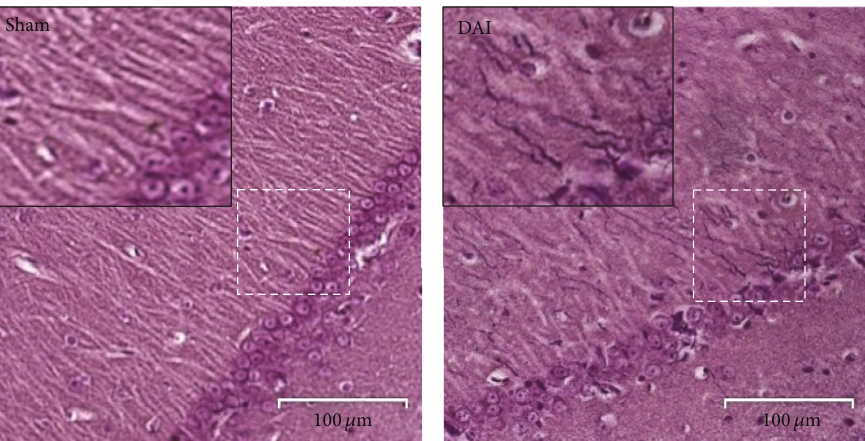
Figure 1: PTAH staining to evaluate DAI animal model. The neuronal axon was intact in normal brain tissue. At 24 h after DAI, neuronal axon showed irregular cells arrangement. The axons showed clear waving and enlargement with the appearance of axonal